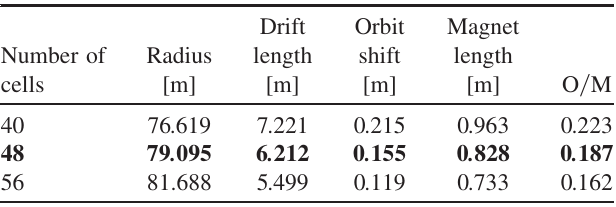
TABLE IV. Geometrical lattice parameters as a function of number of cells for a 6 : 87 GeV =c machine, that is a kinetic energy of 6 GeV for a proton.